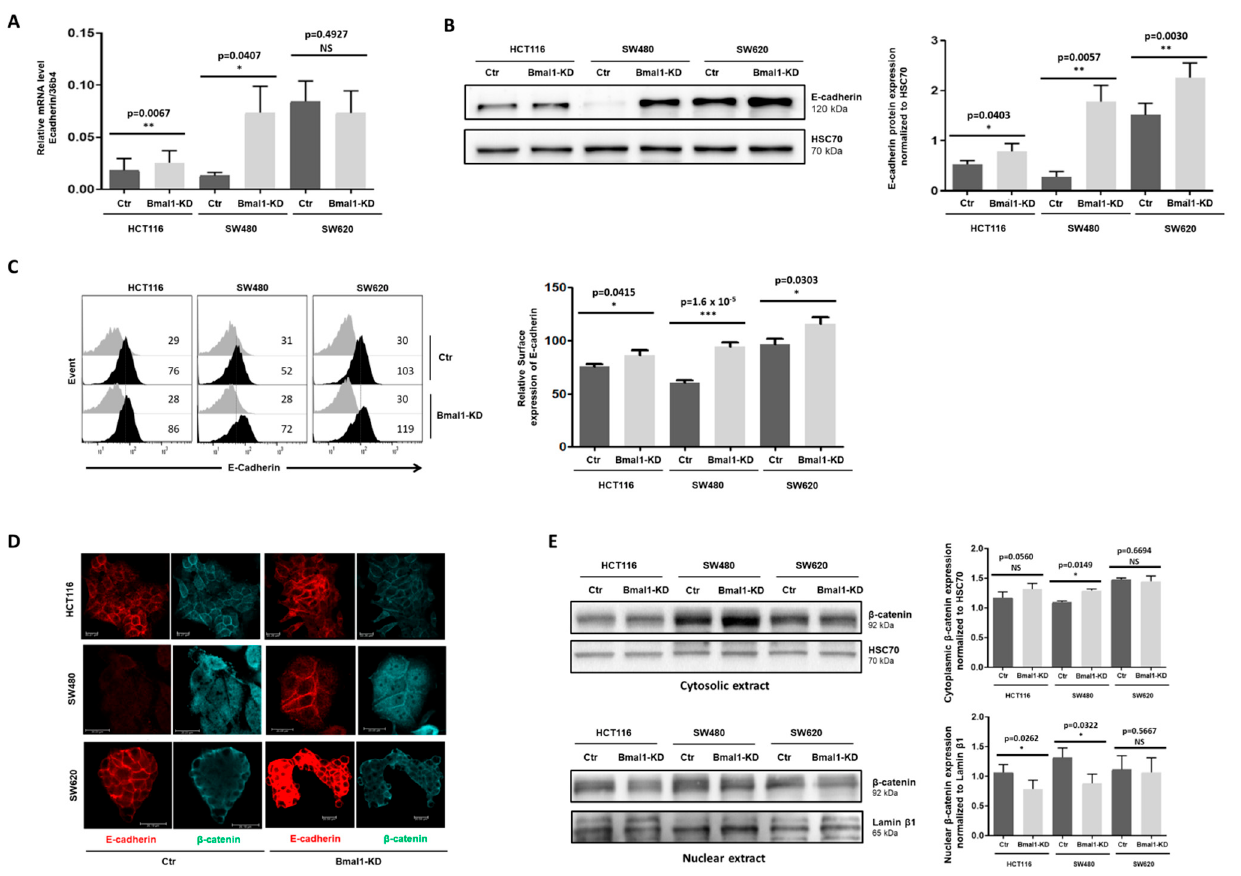
Figure 2. BMAL1-KD increased the plasma membrane colocation of E-cadherin and β -catenin but decreased β -catenin nuclear location. ( A ) Quantitative RT-PCR assay revealed an increased E-cadherin expression in two primary BMAL1 knockdown (BMAL1-KD) cell lines ( n = 4, * p < 0.05, ** p < 0.01) in comparison to control (Ctr) cells. ( B ) Increased E-cadherin expression in BMAL1-KD CRC cell lines was checked by Western blot. Left, Representative Western blots of 6 independent experiments are shown. Right, Bar charts represents E-cadherin expression normalized to HSC70 ( n = 6,* p < 0.05, ** p < 0.01). All data are shown as means ± SEM. ( C ) Enhanced E-cadherin surface expression on BMAL1-KD CRC cell lines was ascertained by flow cytometry analysis. Left, Representative staining of one experiment are shown. Cell staining with the anti-E-Cadherin antibody is represented by the dark-colored histograms and staining with the isotype-matched control antibody correspond to the gray histograms. At the right of each histogram are shown the mean fluorescence intensity values for each staining. Right, Graphs represent the relative expression of E-cadherin in three independent experiments (* p < 0.05, *** p < 0.001). ( D ) Confocal laser scanning microscopy showing stainings for E-cadherin (red) and β -catenin (blue). BMAL1-KD promotes elevated levels of E-cadherin and β -catenin at the plasma membrane of both HCT116 and SW480 cells, whereas BMAL1-KD only increased evidently the membrane localization of E-cadherin but not β -catenin in SW620 cells. Scale bars, 20 μ m. These data are representative of three independent experiments. ( E ) Cytoplasmic (upper panels) and nuclear (lower panels) extracts of BMAL1-KD and control (Ctr) cell lines were analyzed by Western blot. Left, Representative stainings of one experiment are shown. Right, Graphs represent the quantification of Western blot signals, corresponding to β -catenin expression normalized to HSC70 (cytoplasmic extracts) or Lamin β 1 (nuclear extracts). Data are represented as means ± SEM for 5 independent determinations (* p < 0.05). A significant increase in β -catenin cytoplasmic localization was found in SW480 BMAL1-KD cells. HCT116 BMAL1-KD cells presented an increased tendency of cytoplasmic β -catenin ( p = 0.056). A significant decrease in β -catenin nuclear localization ( n = 5, * p < 0.05) was found in the SW480 BMAL1-KD and HCT116 BMAL1-KD cell lines. Western blot on cytoplasmic and nuclear extracts of BMAL1-KD and control CRC cell lines were applied to analyze the localization of β -catenin in the different cell frac- tions (Figure 2E). Consistently with IF experiments, a significant increase in β -catenin